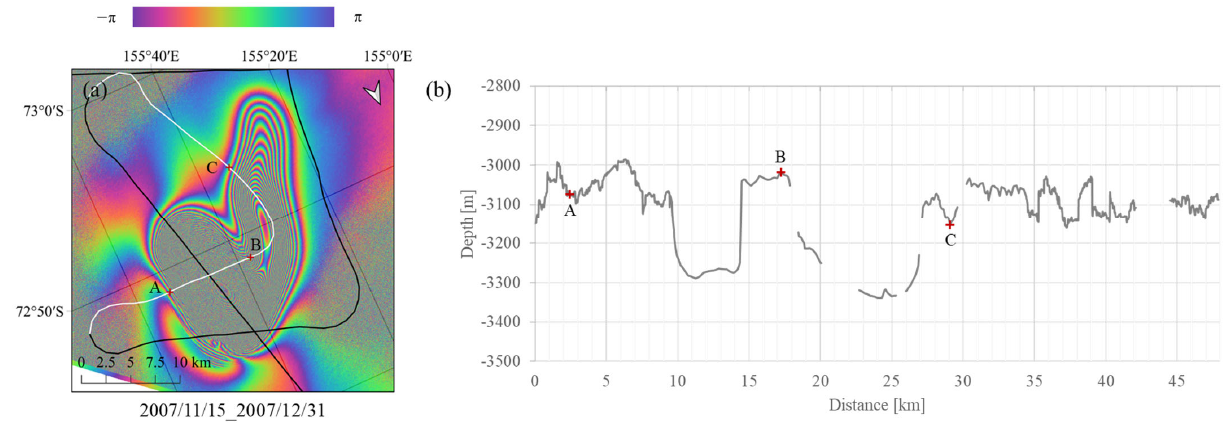
Figure 11. Radar sounding data from the MCoRDS5 airborne radar. ( a ) shows the path from which the radar sounding data was acquired. The black line represents the track in segment ID 04 and the white line represents frame number 010, which is part of it; ( b ) is the depth of ice bottom observed by MCoRDS5. Each A, B, and C represents the same point. The flight direction goes through A, and B, then through C.